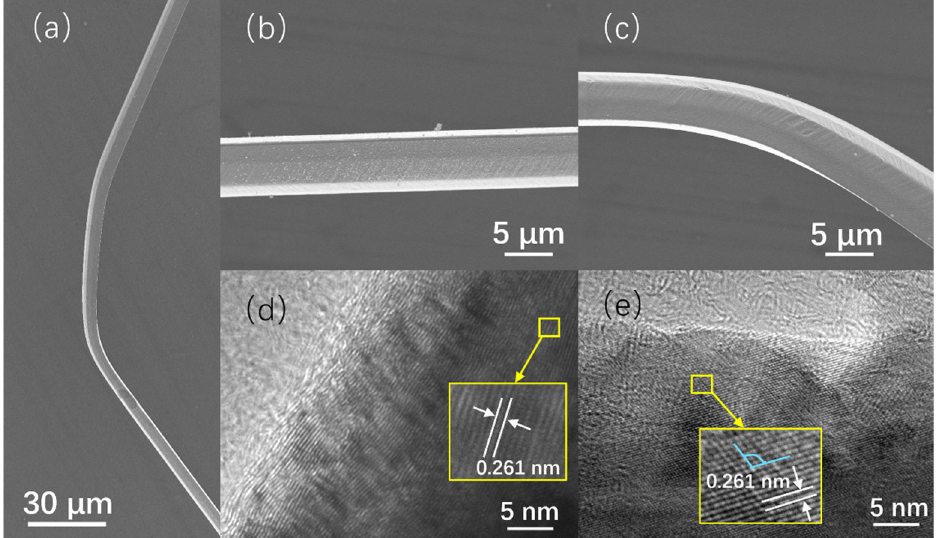
Figure 2. SEM image of the ZnO microwire after bending. ( a ) SEM image of whole bent regions. ( b , c ) SEM images of the unbent and bent regions of the ZnO microwire, respectively. ( d , e ) The corresponding SAED patterns of the unbent and bent regions of the ZnO microwire.